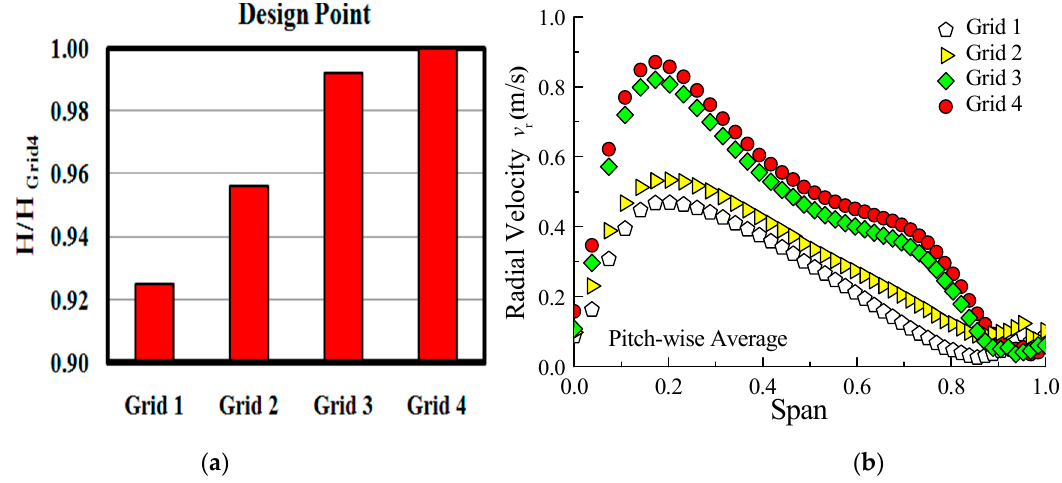
Figure 4. Grid independency analysis—( a ) Normalized pump head at design point; ( b ) Pitch-averaged, spanwise distribution of the radial velocity at the impeller blade leading edge, at design point.